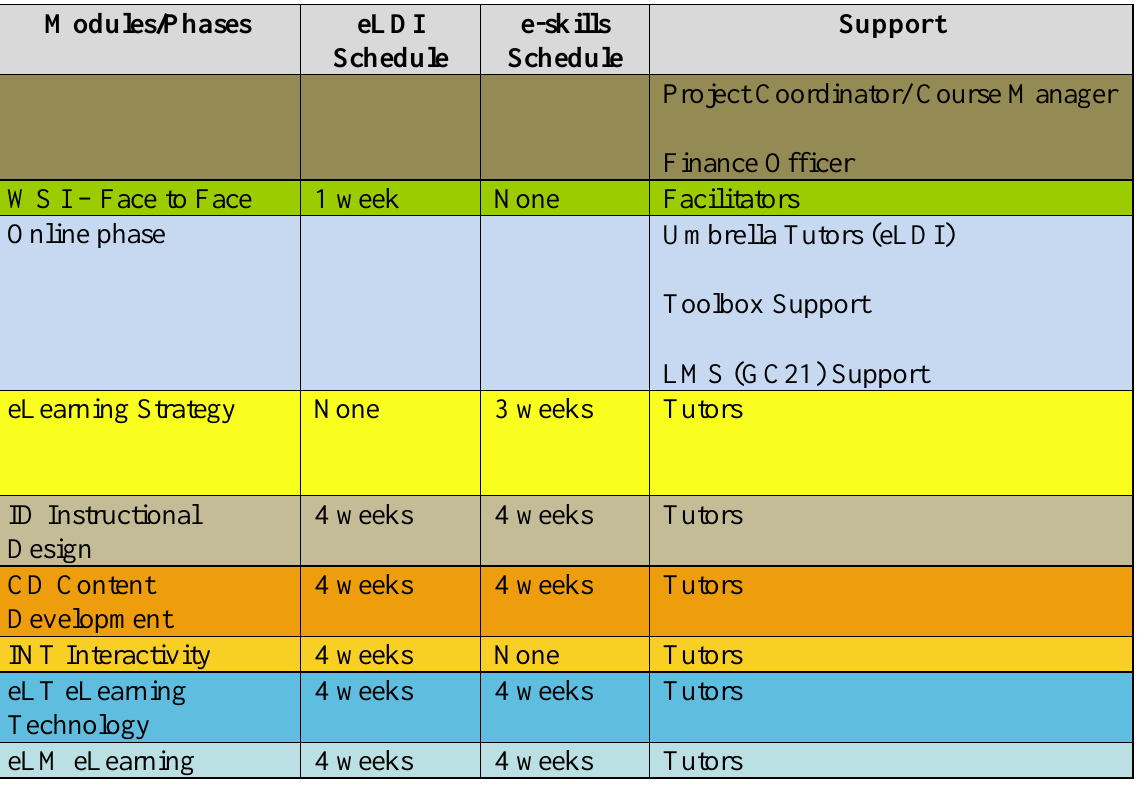
Table 1. Program Content and Support eLDI and